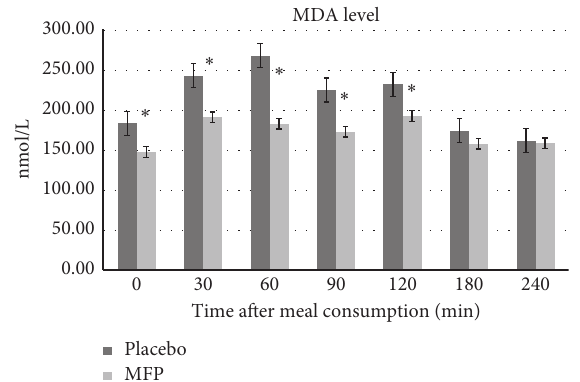
Figure 5: Postprandial blood MDA level in the MFP jelly and placebo test, data expressed as mean ± SE. ∗ Statistically significant with p value <